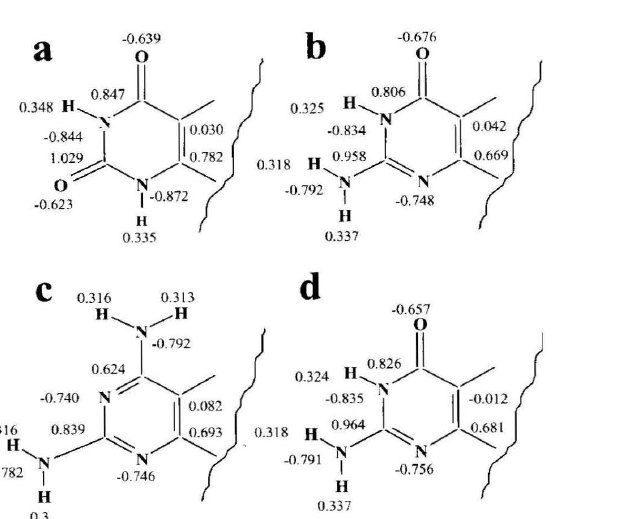
figure 2. Partial charges of the atoms in the pyrimidine moiety of the pterin ring system of d1C compounds studied. a) tetrahydrolumazine, b) tetrahydropterin, c) 4- amino tetrahydropterin, d) N5-methyl